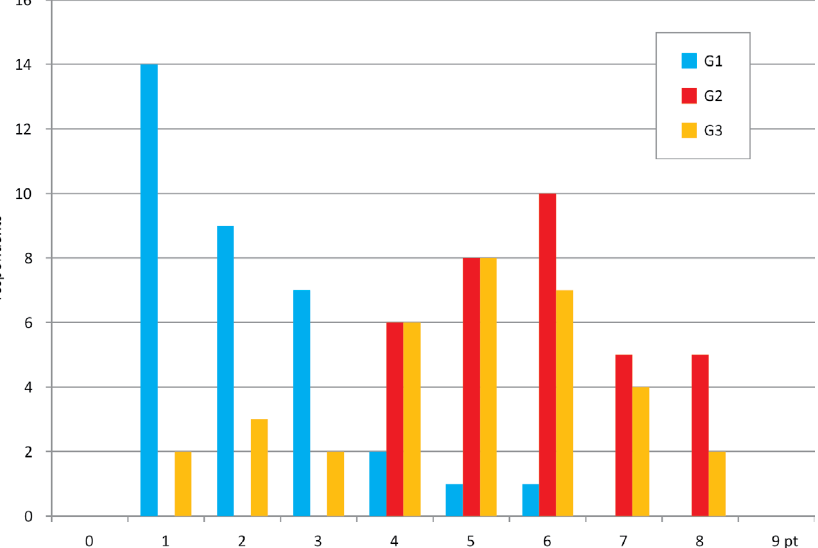
Fig. 4. The comparative graph for frequencies in the respective experimental groups: G1 – smooth condition, G2 – abrupt condition, G3 – abrupt with decay effect